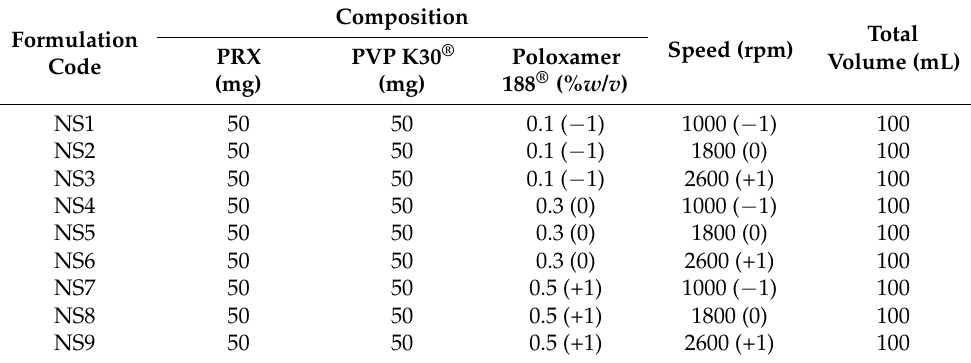
Table 1. 3 2 full factorial design with composition and independent